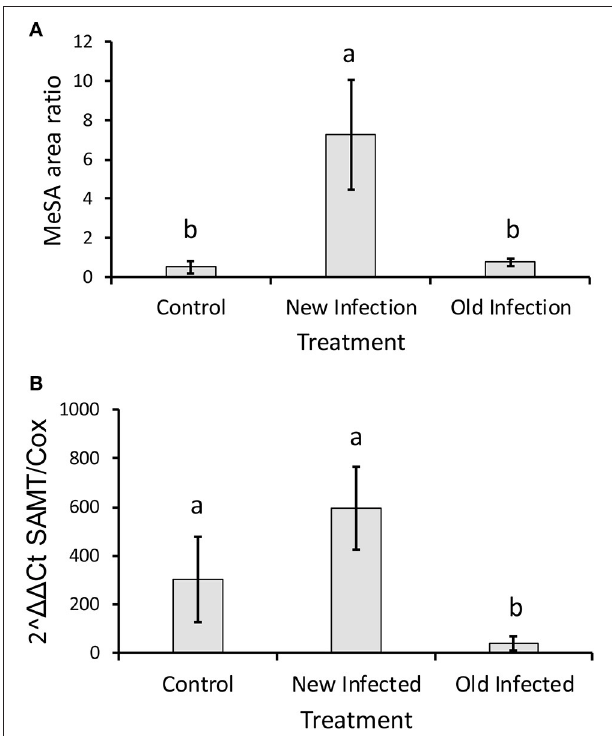
FIGURE 4 | (A) Release of methyl salicylate by young infected, old infected, and uninfected citrus plants. The rates are measured as a ratio of the peak area of MeSA compared to the internal standard (nonyl acetate). (B) Expression of the gene SAMT compared to cox gene in newly infected, long-infected, and uninfected citrus plants. Different letters indicate significant difference ( P < 0.05) among